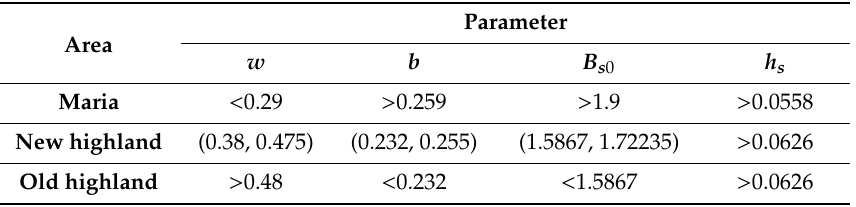
Table 1. The range of Hapke model parameters for the three areas.